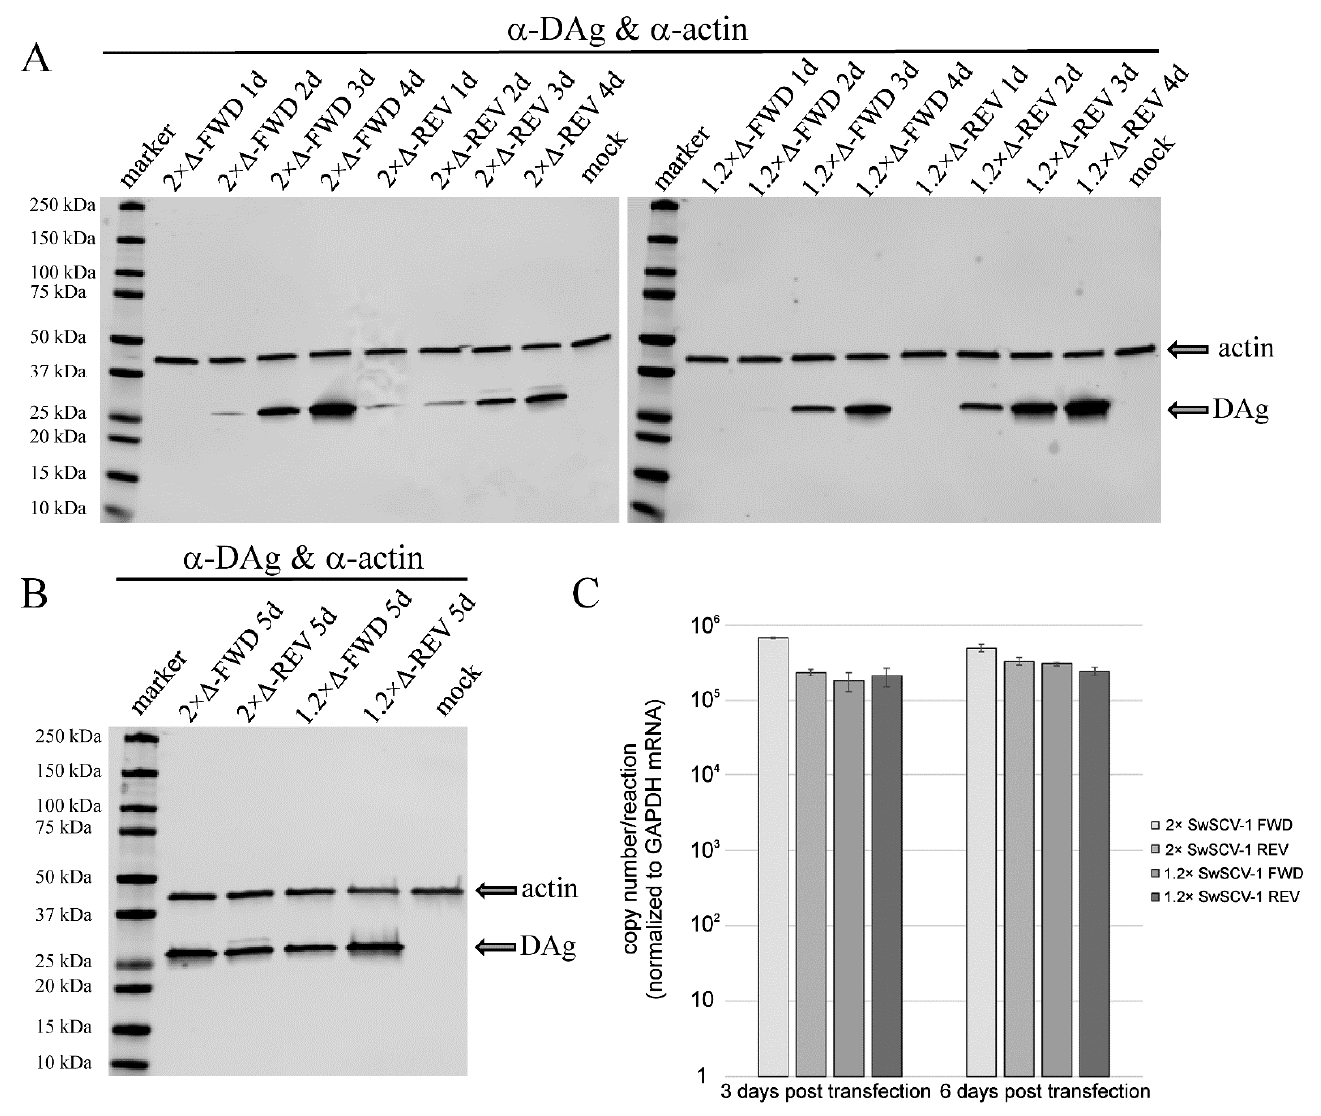
Figure 4. Western blot of I/1Ki cells after transfection with 2 × and 1.2 × SwSCV-1 (2 × ∆ and 1.2 × ∆ , respectively) FWD and REV constructs. ( A ) Samples of I/1Ki cells transfected with 2 × ∆ -FWD, 2 × ∆ -REV, 1.2 × ∆ -FWD, and 1.2 × ∆ -REV constructs collected at 1–4 days post transfection were separated on 4–20% Mini-PROTEAN TGX gels (Bio-Rad, Hercules, CA, USA), transferred onto nitrocellulose, and the membranes were probed with rabbit α -SwSCV-1 DAg antiserum and mouse monoclonal anti-pan actin antibody. The left panel shows 2 × and the right panel 1.2 × genome constructs. The results were recorded using Odyssey Infrared Imaging System (LI-COR Biosciences, Lincoln, NE, USA). ( B ) Samples of I/1Ki cells transfected with 2 × ∆ -FWD, 2 × ∆ -REV, 1.2 × ∆ -FWD, and 1.2 × ∆ -REV constructs collected at 5 days, analyzed as described in ( A ). ( C ) RNA isolated from I/1Ki cells transfected with 2 × ∆ -FWD, 2 × ∆ -REV, 1.2 × ∆ -FWD, and 1.2 × ∆ -REV constructs at 3 and 6 days post transfection were analyzed by qRT-PCR targeting genomic SwSCV-1 RNA. In vitro transcribed RNA target served for obtaining a standard curve to convert cycle threshold values into copy numbers. qRT-PCR targeting GAPDH mRNA served for normalizing the results between samples. The y-axis shows copy numbers/reaction. The error bars represent standard